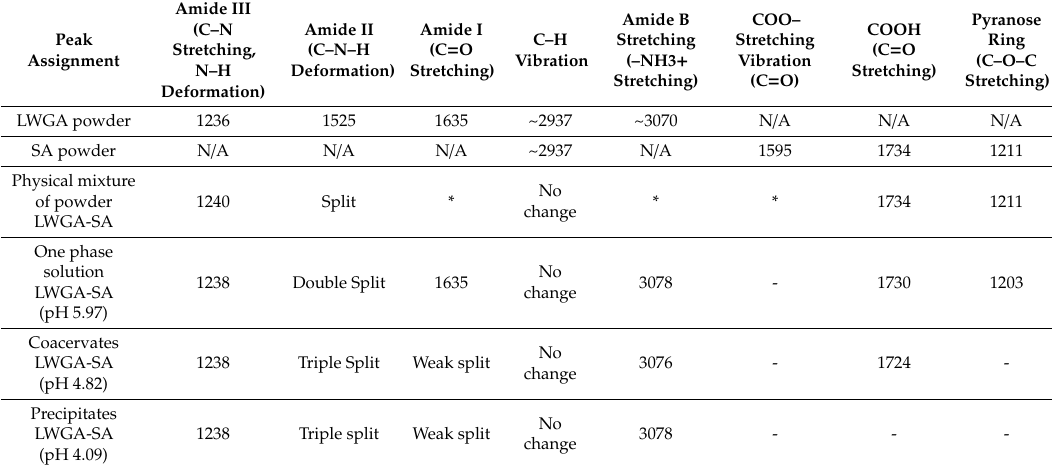
Table 3. Assignments of major bands in FTIR of LWGA, SA, and their mixtures (1:0.4) in various